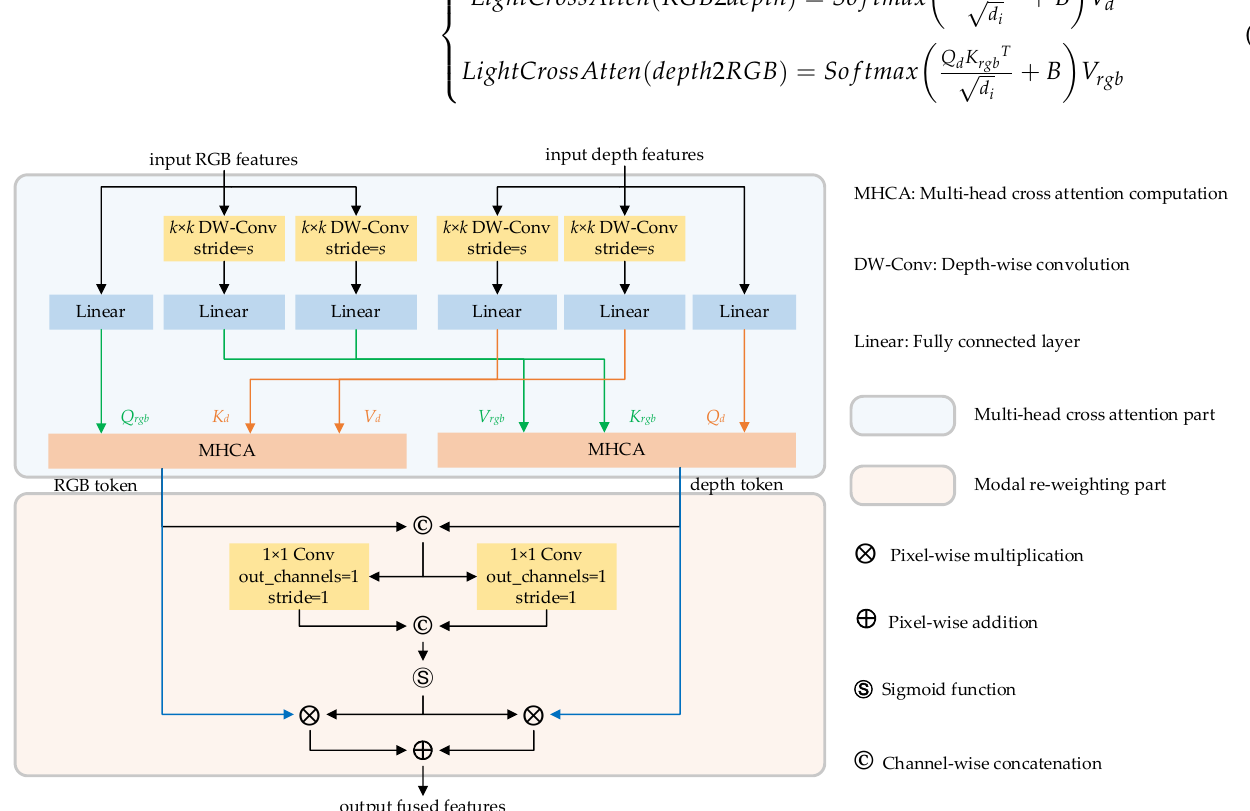
Figure 8. Multi-head cross-attention block diagram. RGB and depth tokens are exported according to the upper operation. These two tokens are concatenated and fed into the modality reweighting process to create fused features. Different from the strategy of [39], we developed a novel modal reweighting method and assign appropriate adaptive weights to RGB and depth tokens, respectively, to obtain effective fused features. The detailed structure of the modality reweighting strategy can be seen in the bottom half of Figure 8. First, we concatenate the RGB and depth tokens, tokens and adding them at the pixel